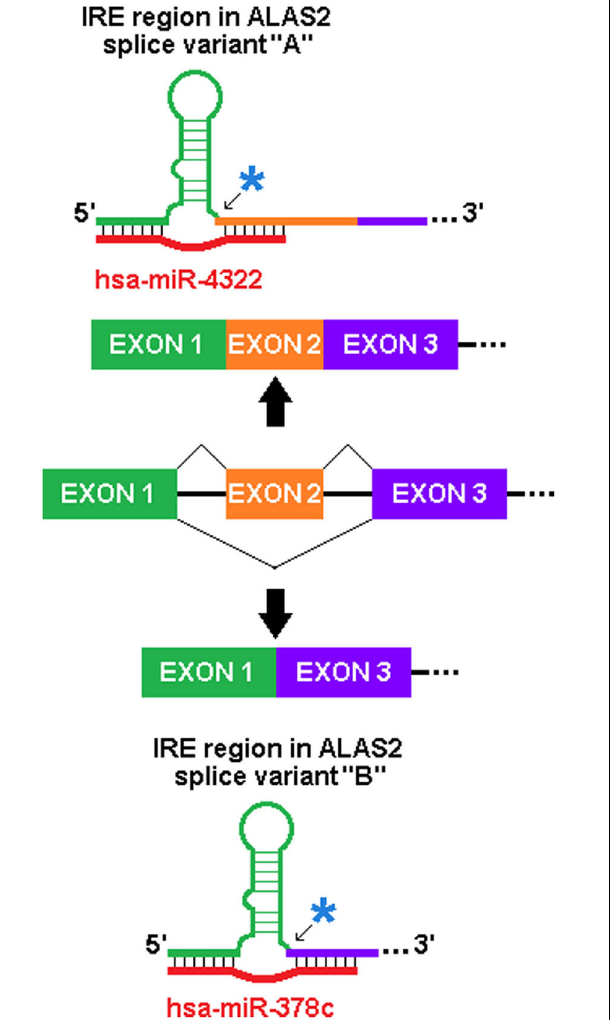
FIGURE 5 | Potential of sxRNA Targeting to Affect Alternative Splicing. The incorporation of an alternatively spliced exon immediately 3 (cid:2) of the base of the IRE stem (noted by blue asterisks and arrows) in ALAS2 mRNA transcript variants alters which miRNA is predicted to interact (variant “A” uses RefSeq Accession NM_001037968 and “B” uses NM_001037967). This particular sxRNA interaction suggests a possible influence on the alternative splicing process and may be indicative of sxRNA post-transcriptional modulators being coupled to transcriptional regulation. Note: The IRE, and genomic exons and introns are not depicted to